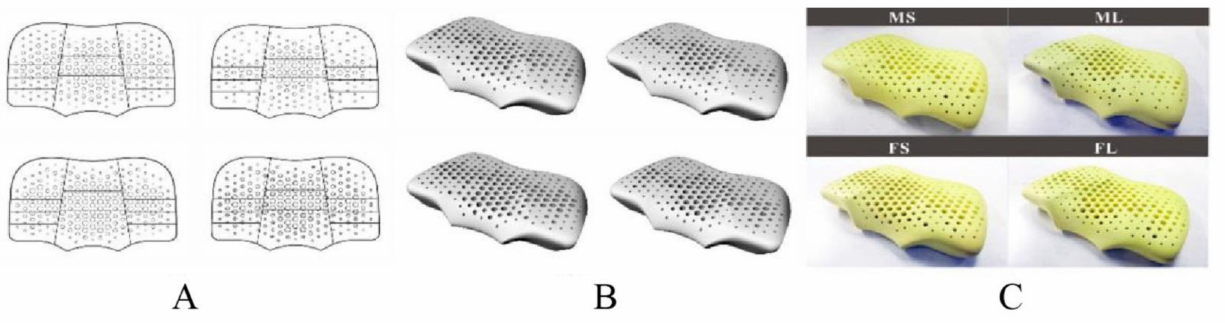
Figure 8. Pillow prototypes made of pore-array structure with different apertures: ( A ) partition and array; ( B ) three- dimensional model; ( C ) standard pillow prototype [2] (open